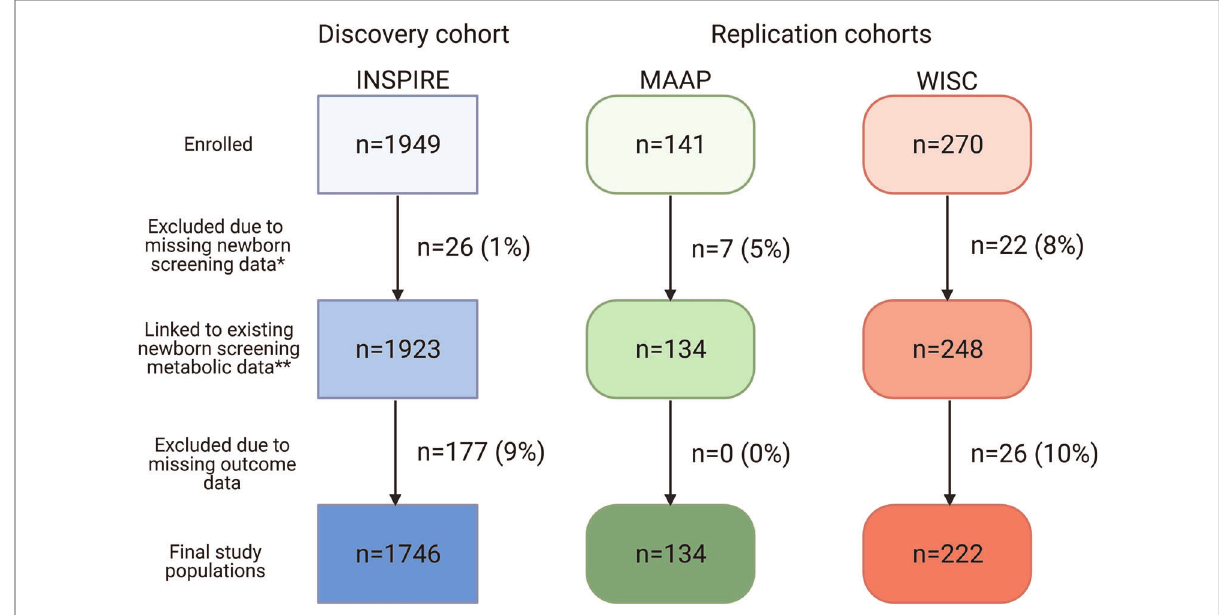
FIGURE 1 Flow diagram of study populations. Discovery cohort: INSPIRE, Infant Susceptibility to Pulmonary Infections and Asthma following RSV Exposure; Replication cohorts: MAAP, Microbes, Allergy, Asthma and Pets study and WISC, Wisconsin Infant Study Cohort. *Newborn screening data may have been missing due to refusal of newborn screening, metabolite concentrations outside the normal range, or incomplete linkage. **The study population included in the RSV sub-analysis ( n =912 INSPIRE infants) stemmed from this box. This fi gure was created with